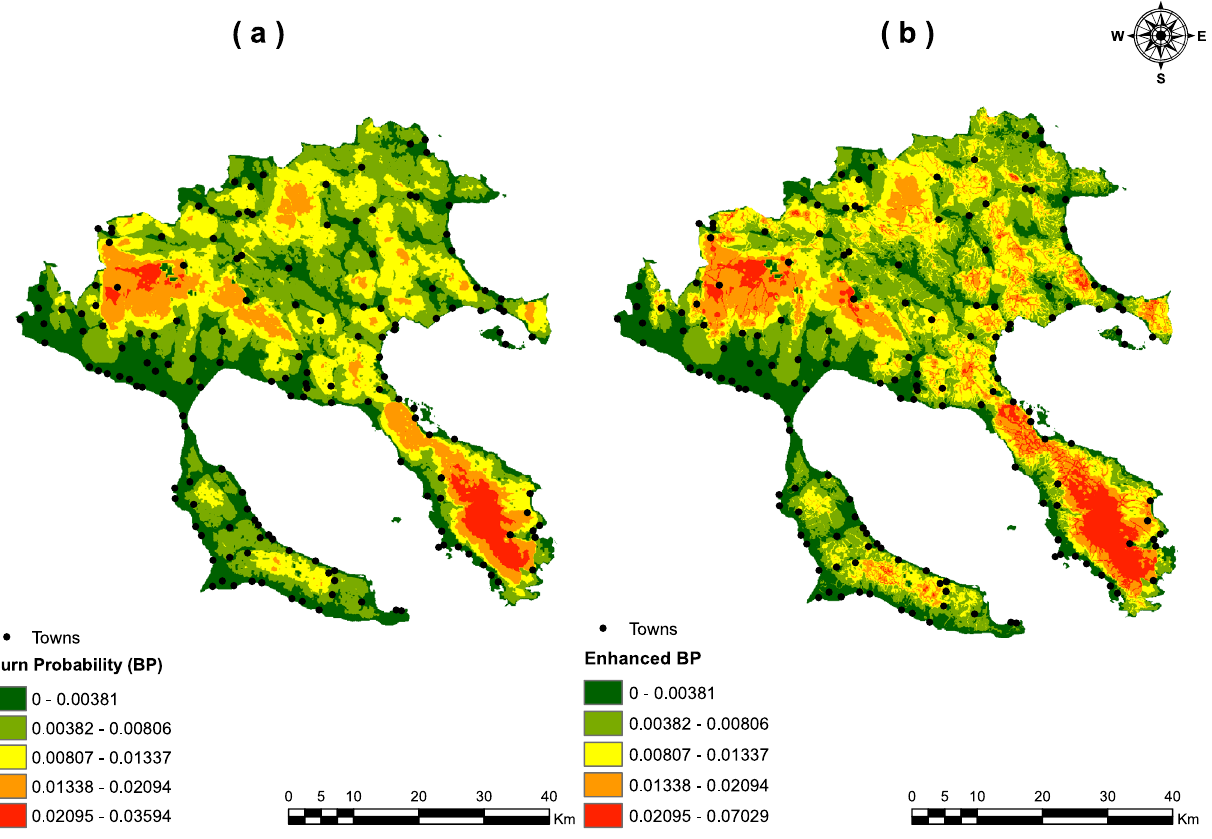
Fig. 3 a Original burn probability (BP) map from Sakellariou et al. (2022b), adjusted; b Integration of anthropogenic effect on BP—Enhanced BP map for the Chalkidiki study